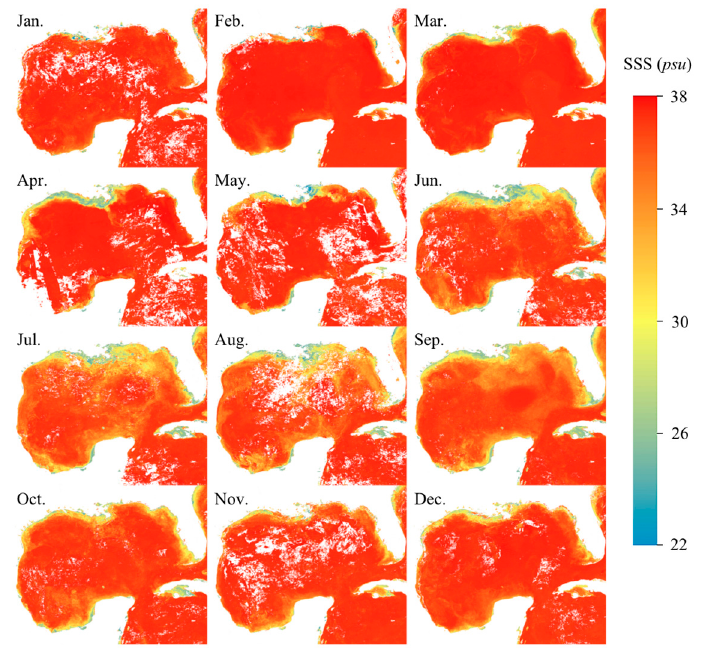
Figure 7. Monthly map of SSS in the GOM, derived from MODIS using the cubist model for 2018. It can be seen that the most obvious change occurs in the estuary area, reflecting the seasonal cycle, which may be related to the discharge of rivers, since salinity is largely controlled by fluxes of freshwater into and out of the Gulf [58]. The river discharge data were acquired to analyze the influence of river discharge (Figure 8), downloaded from U.S. Army Corps of Engineers website. Mississippi River at Tarbert Landing (Gate ID 01100Q) and Atchafalaya River at Simmesport (Gate ID 03045Q) capturing the water flow